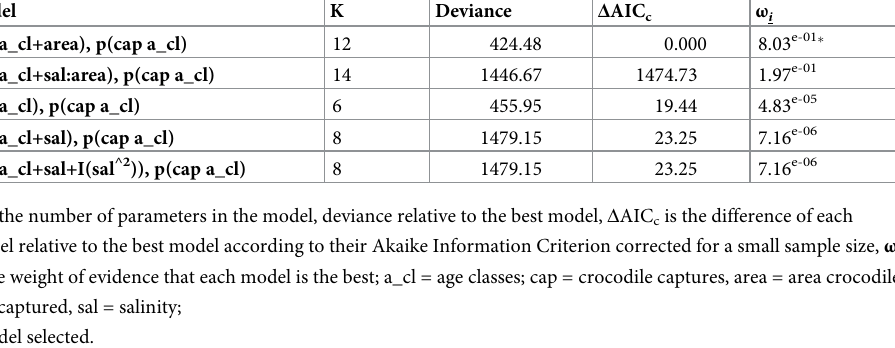
and had a 28% hatchling survival rate.